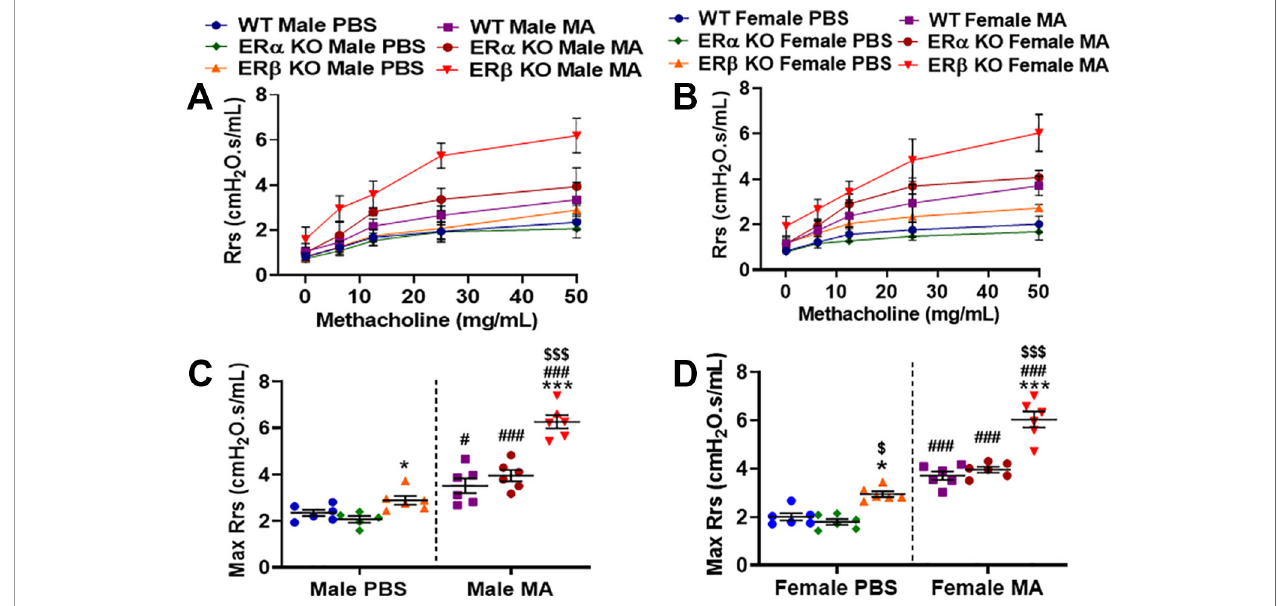
FIGURE 2 | Effect of estrogen receptor (ER) signaling on airway resistance (Rrs) in the lungs of (A) male and (B) female mice (wild type, WT vs. ER a KO vs. ER b KO) exposed to phosphate buffered saline (PBS) and mixed allergen (MA). Max Rrs was used to compare WT, ER a KO and ER b KO in (C) males and (D) female mice exposed to PBS and MA. Data represented as mean ± SEM of at least 5-6 mice per treatment group; # p < 0.05, ### p < 0.001 vs. PBS of respective groups (MA effect), *p < 0.05, ***p < 0.001 vs. WT of PBS/MA (ER speci fi c KO effect) and $ p < 0.05, $$$ p < 0.001 vs. ER a KO of PBS/MA (ER b vs. ER a